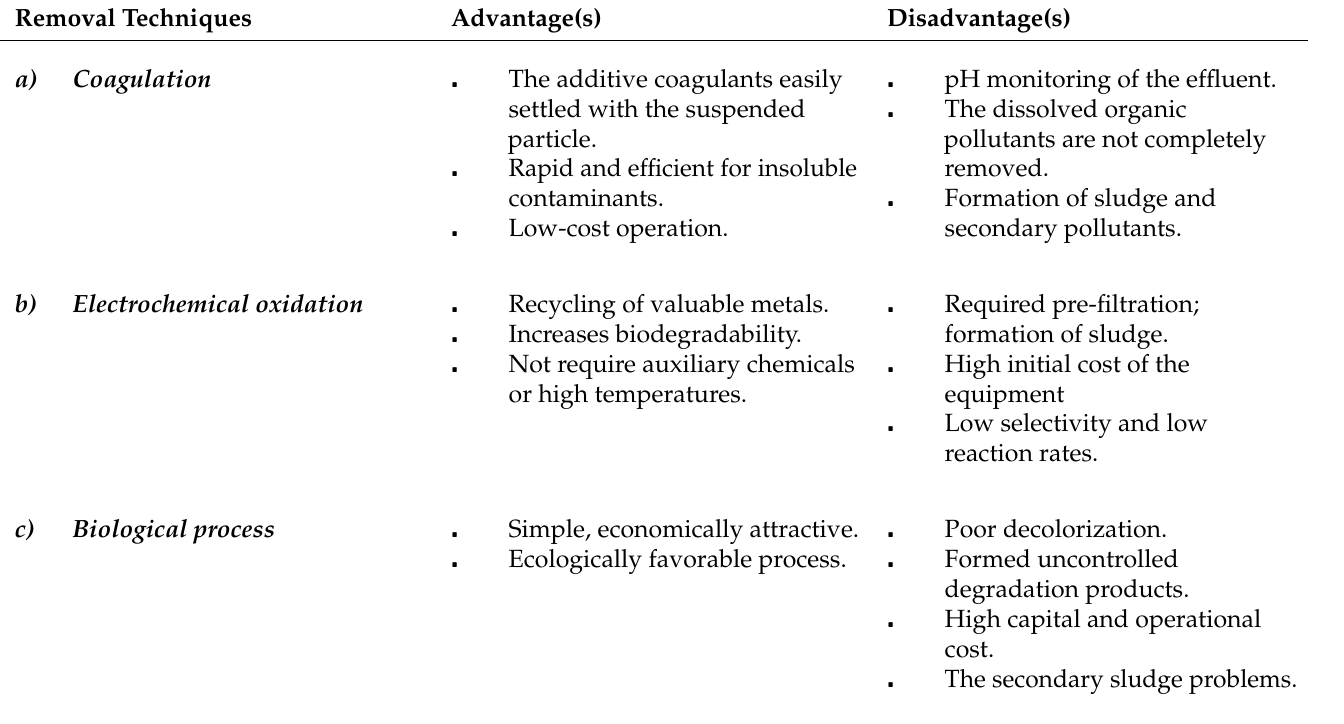
Table 2. Different removal techniques used for wastewater treatment and their advantage(s) and disadvantage(s). Removal